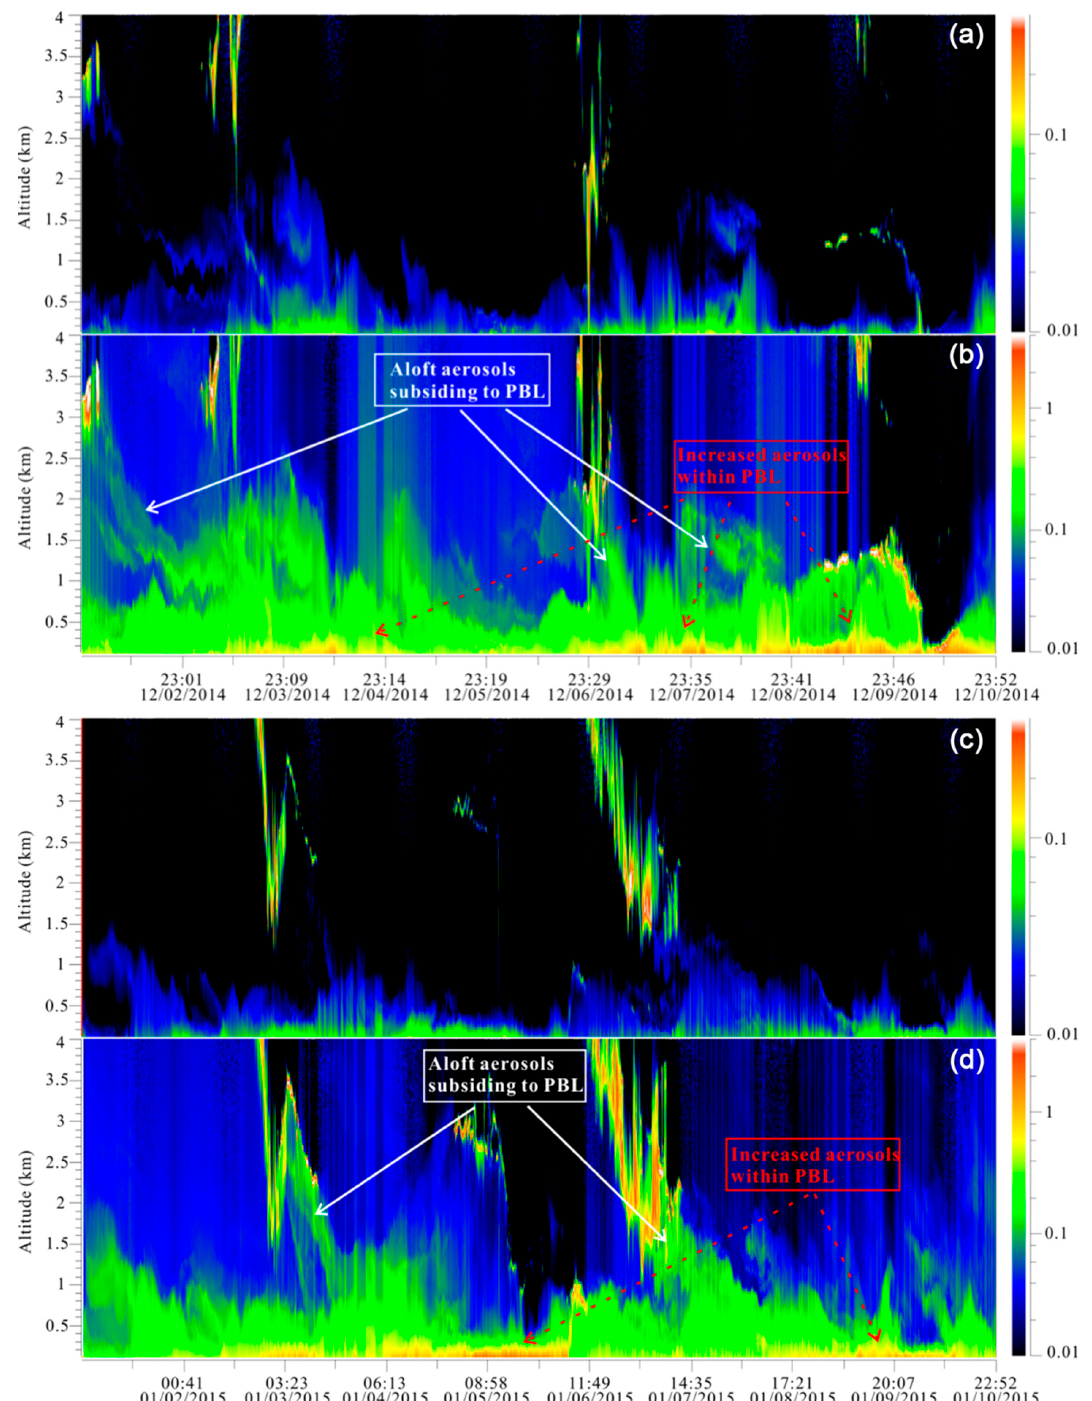
Figure 2. Time–height images of MPL NRB (normalized relative backscatter) at 532 nm in cross- polarization ( a ) and co-polarized ( b ) channels for 2–10 December 2014 and in cross-polarization ( c ) and co-polarized ( d ) channels for 1–10 January 2015 (China Standard Time (CST)).